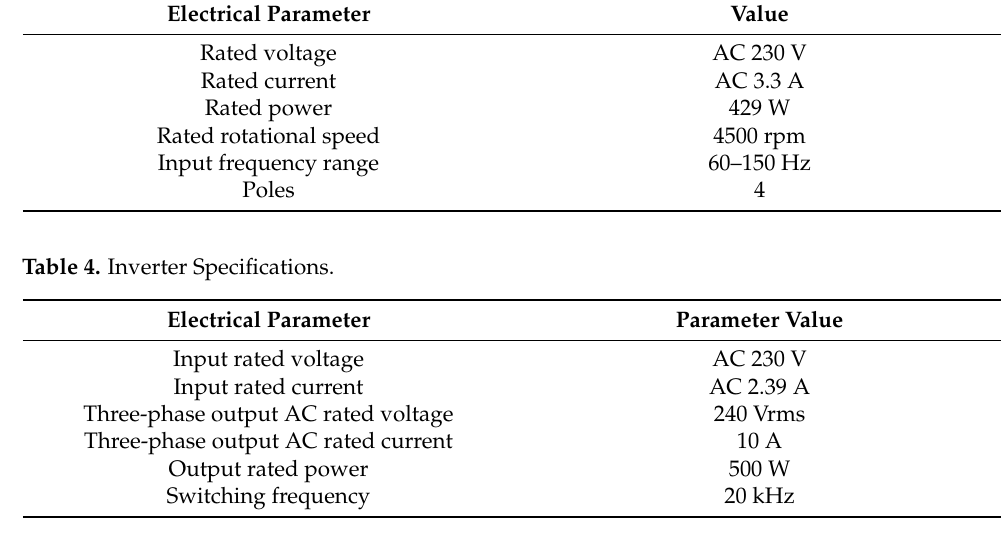
4 Table 4. Inverter Specifications. Electrical Parameter